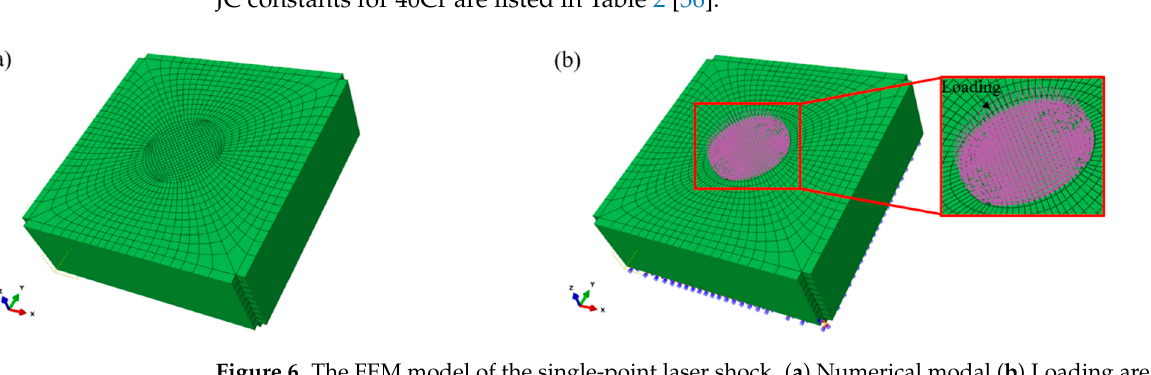
Figure 5. LSP simulation process.